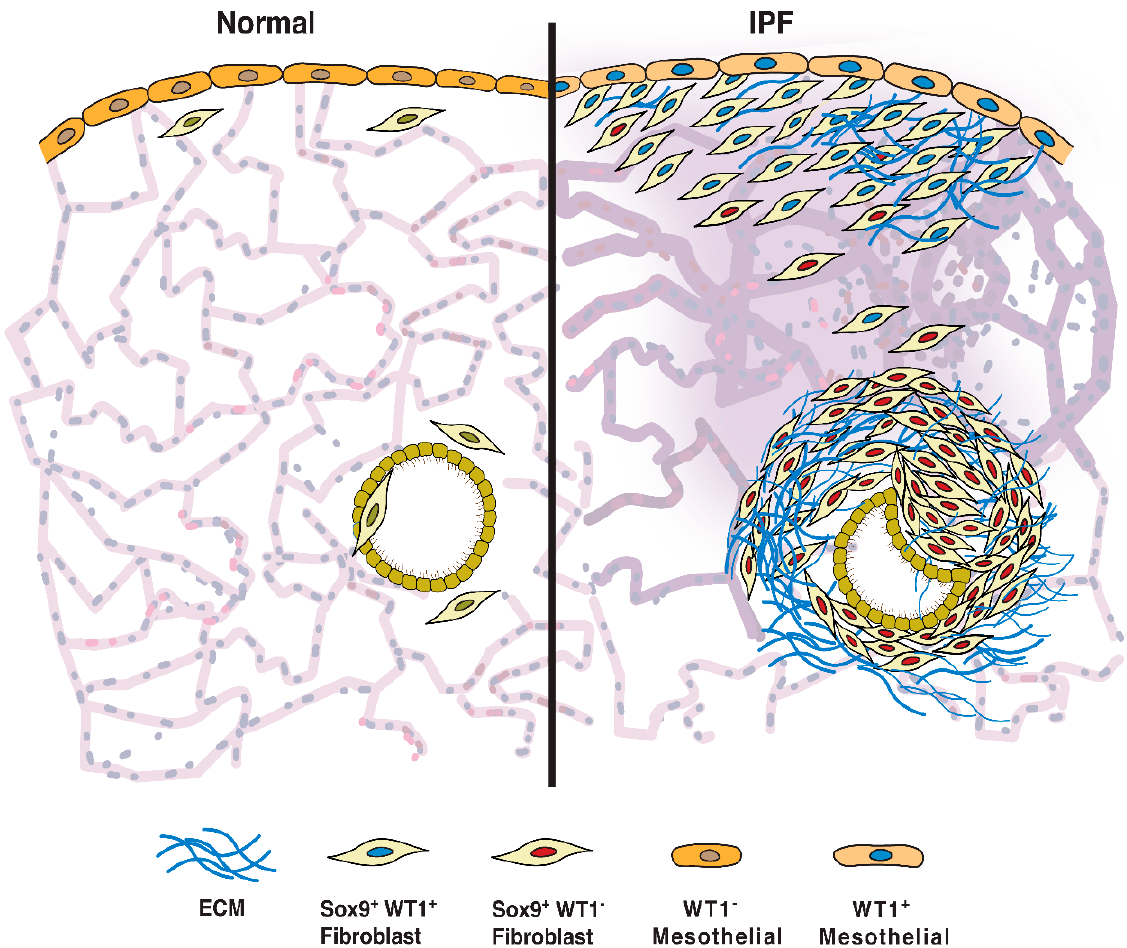
Figure 2. Accumulation of WT1- and Sox9-positive or Sox9-positive fibroblasts in IPF. WT1-mediated Sox9 upregulation in mesothelium and fibroblasts induces accumulation of fibroblasts that are positive for both WT1 and Sox9 in subpleural fibrotic lesions. Additionally, we observed accumulation of Sox9 positive fibroblasts that are negative for WT1 in peribronchial fibrotic lung lesions. Both WT1 and Sox9 expressing fibroblasts can transform to myofibroblasts resulting in progressive accumulation in fibrotic lesions of IPF lungs ( right ) compared to normal lungs ( left ).